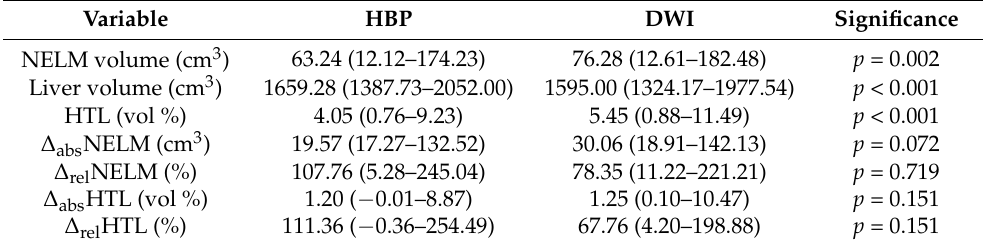
Table 4. Comparison of 3D quantification between HBP and DWI